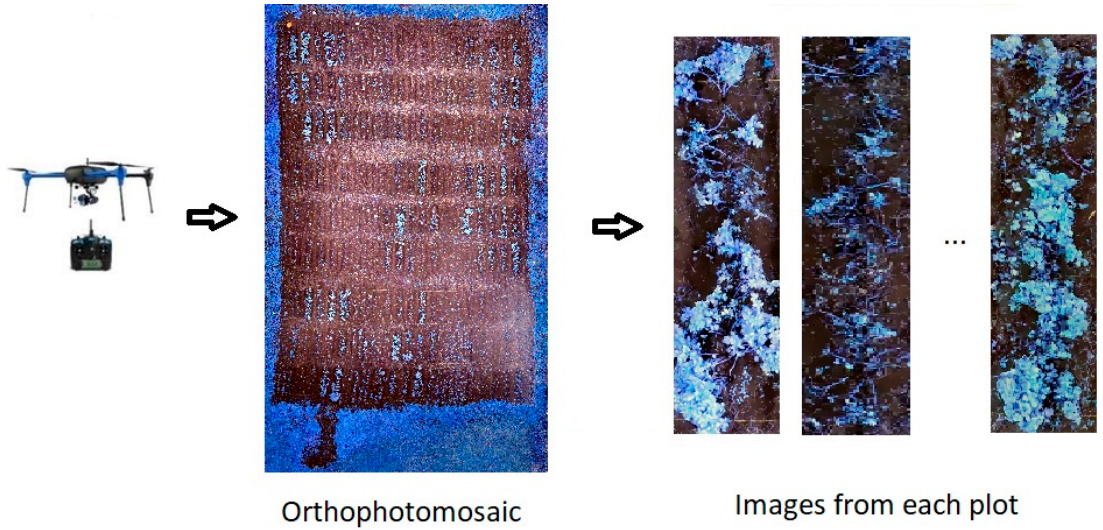
Figure 2. Image acquisition methodology. ( Left ): drone, Center: orthophotomosaic, ( Right ): plot images.